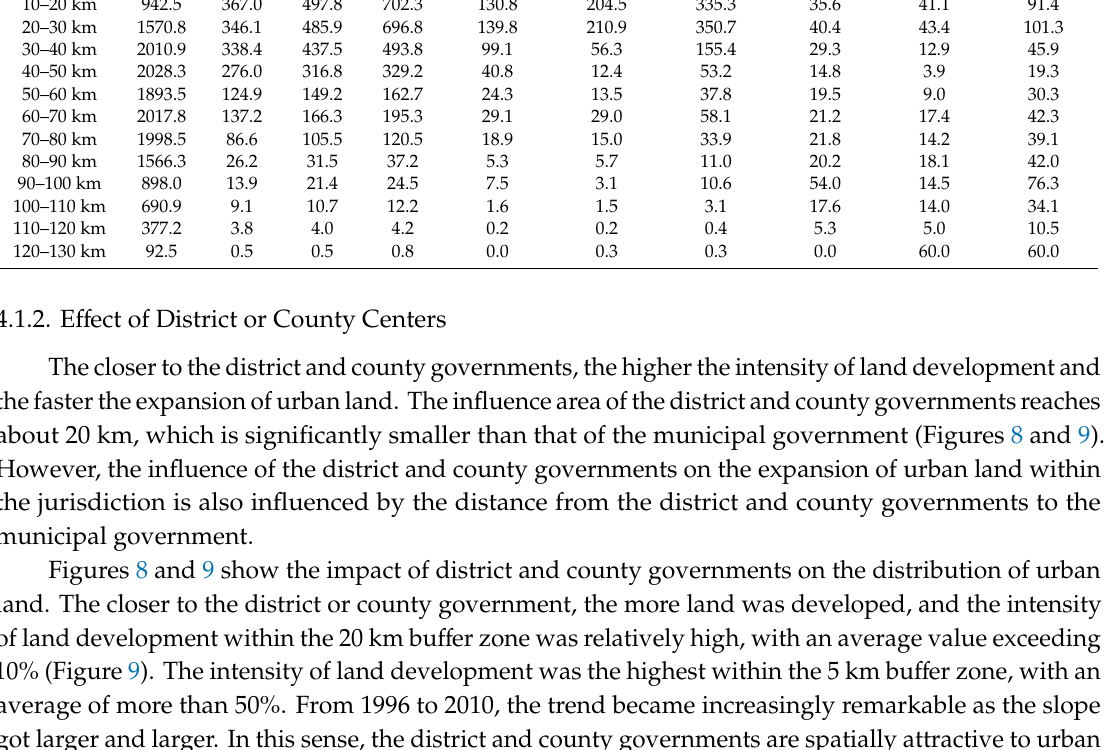
Figure 9. The land development intensity in buffer rings around the distract and county governments. Figure 10 shows different patterns of spatial gradient in the inner and outer suburb. For counties and districts in the outer suburb and remote regions, urban land expands the fastest in areas close to the district and county centers and the growth speed declines gradually with the distance to the centers. In districts near the city center, however, the expansion of urban land is relatively small within 10 km of the district and county governments owing to the high level of land development. The Buffer zone 10–15 km from the district and county governments has the greatest urban land expansion intensity among the near suburbs. The expansion of urban lands at the district and county levels is affected by the dual influence of the locations of municipal government and the district and county governments. In general, the closer the area to the district and county governments, the faster the expansion of urban land. Moreover, the closer the distance from district and county governments to the municipal government, the smaller the influence of district and county governments on the expansion speed of urban land. (1) In the central urban area closest to the municipal government, most of the land has been developed owing to the long ‐ term influence of the municipal government. (2) In the inner suburbs, the district and county governments are close to the municipal government. The urban land